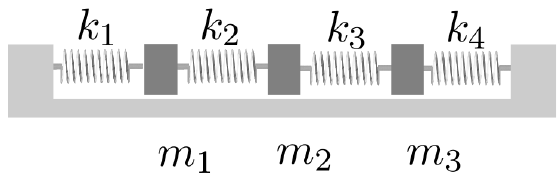
Figure 6. Springs connecting three